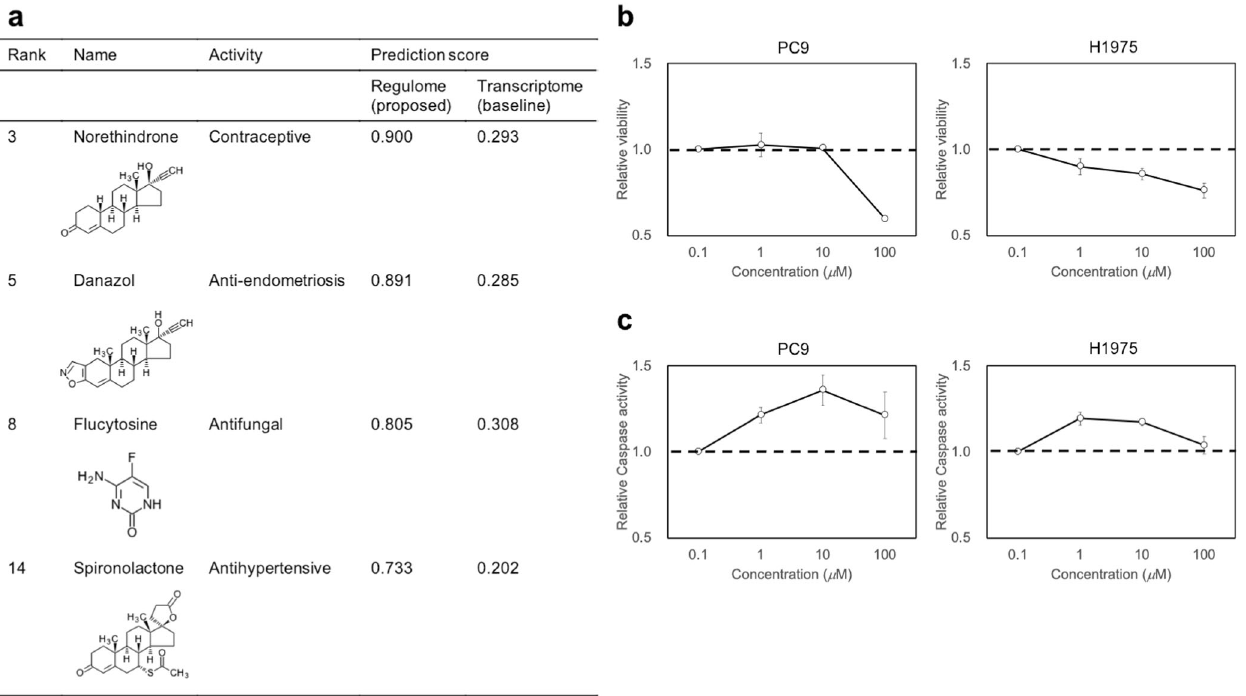
Fig. 5 Experimental validation of predicted anticancer effects of drugs. a List of tested drugs and their chemical structures. b The effect of an anti-endometriosis drug, danazol, on the viability of nonsmall cell lung cell lines. c The effect of danazol on the apoptosis induction. Cell lines were treated with various concentrations of danazol. The horizontal axis represents the concentration on a logarithmic scale. The vertical axis represents the relative viability and relative apoptosis induction (caspase activity). Plot shows means and standard deviations for triplicate